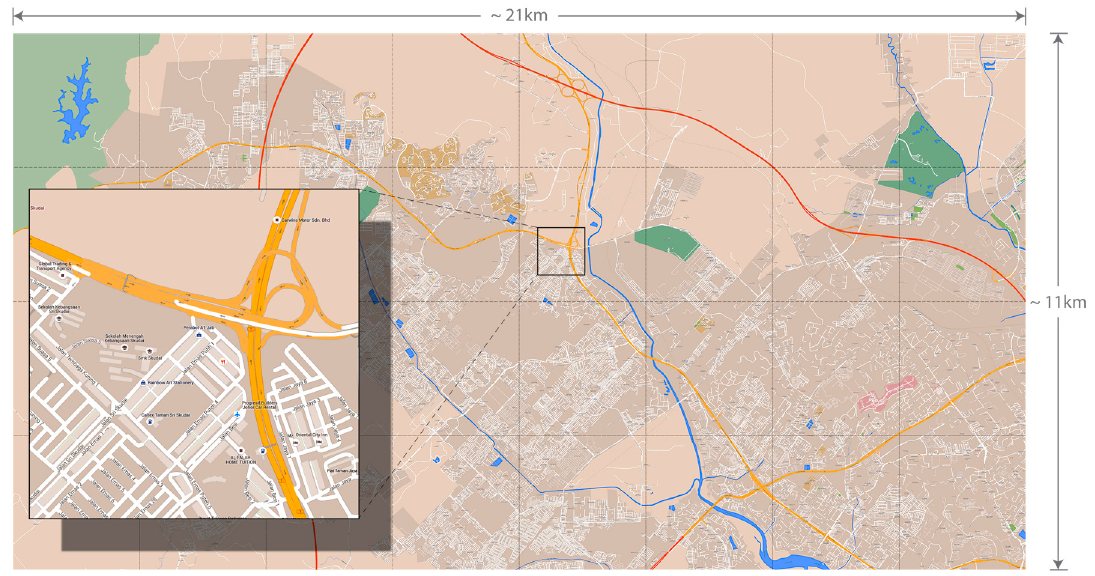
Figure 7. The Skudai simulation area (map data provided by OpenStreetMap, 2015).